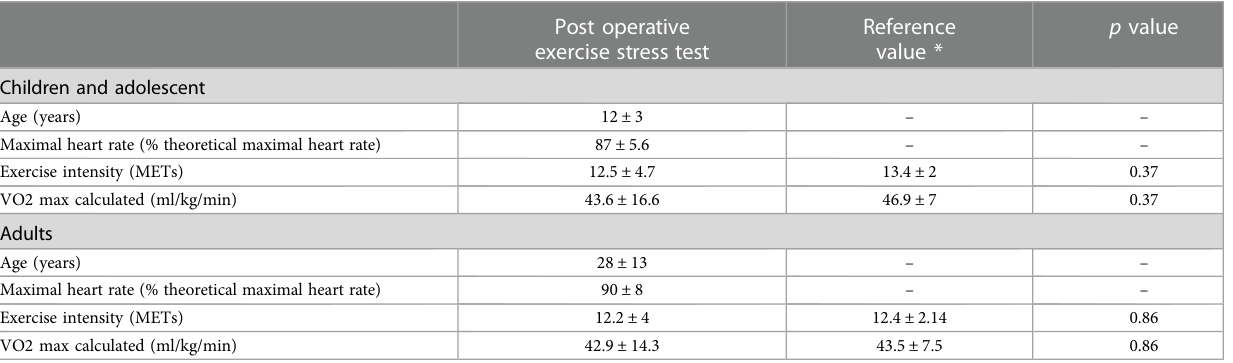
TABLE 3 Post operative exercise stress